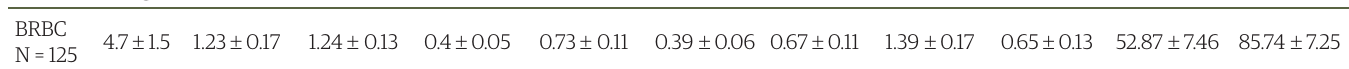
Table 3. Echocardiography measurements (mean ± standard deviation) of Brazilian random bred cats (BRBC). Weight Variant